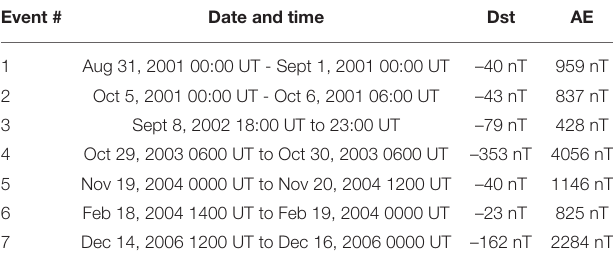
TABLE 1 | List of all geospace events studied in the present work.